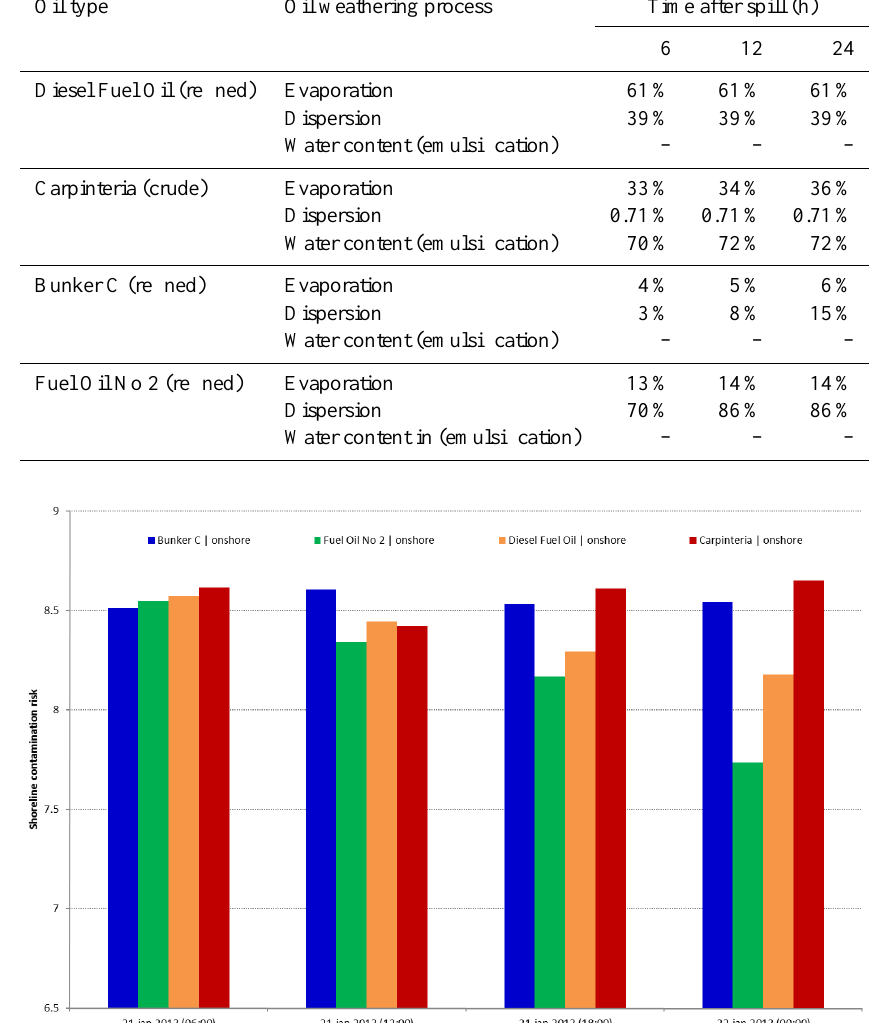
Figure 16. Integrated shoreline contamination risk levels at different time instants from 21 and 22 January 2013, obtained using four